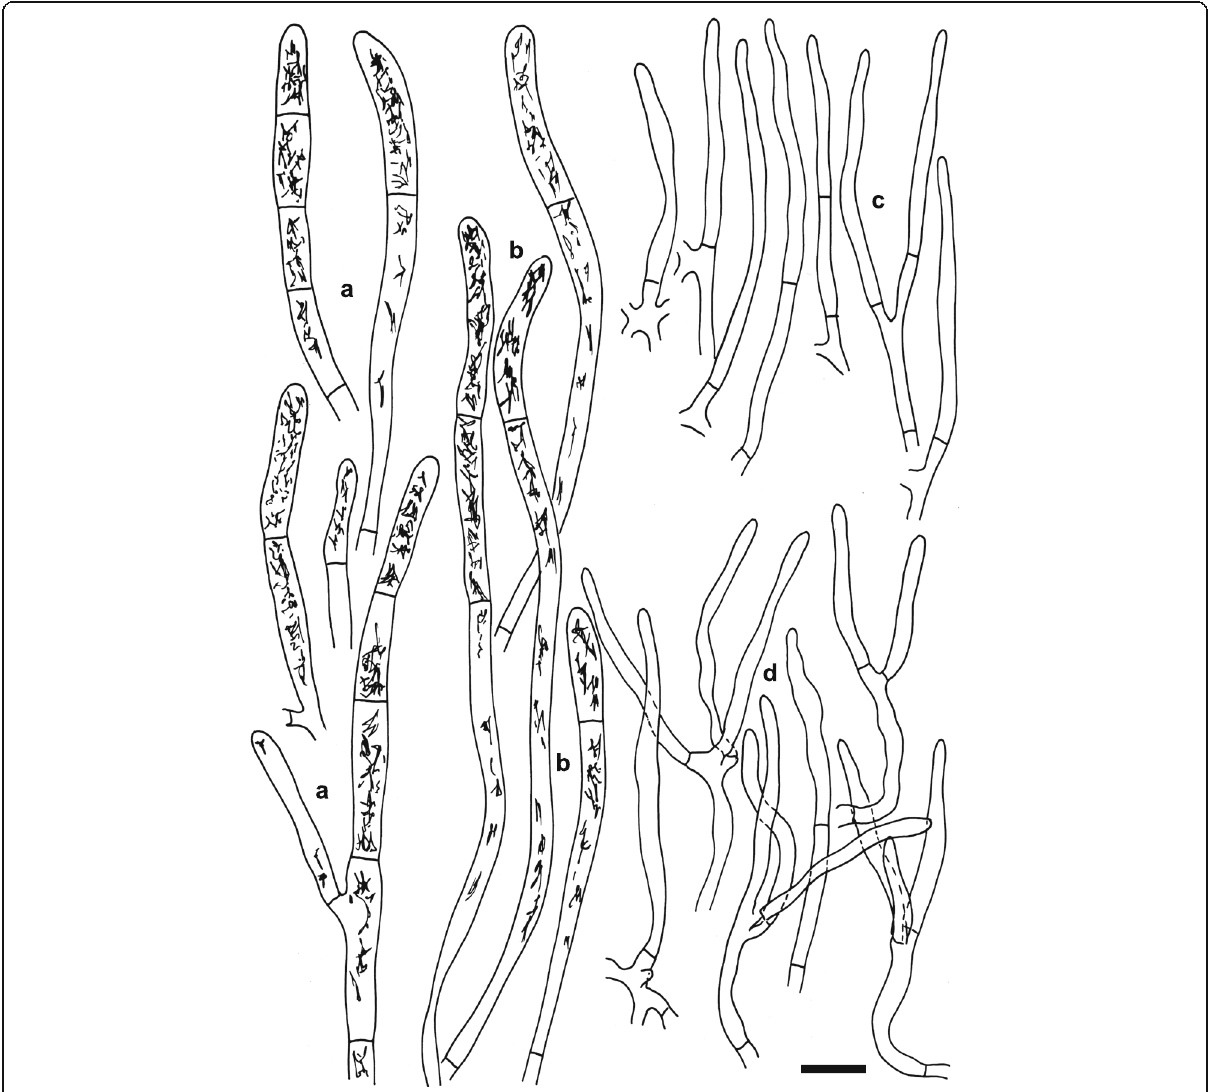
Fig. 9 Russula abbottabadensis (FH00304589, holotype). Microscopic features of the pileipellis. a. Pileocystidia near the pileus centre. b. Pileocystidia near the pileus margin. c. Hyphal terminations in the pileus centre. d. Hyphal terminations near the pileus margin. Contents of cystidia are represented as observed in Congo red. Bars = 10 μ m. Drawings: S.A. &